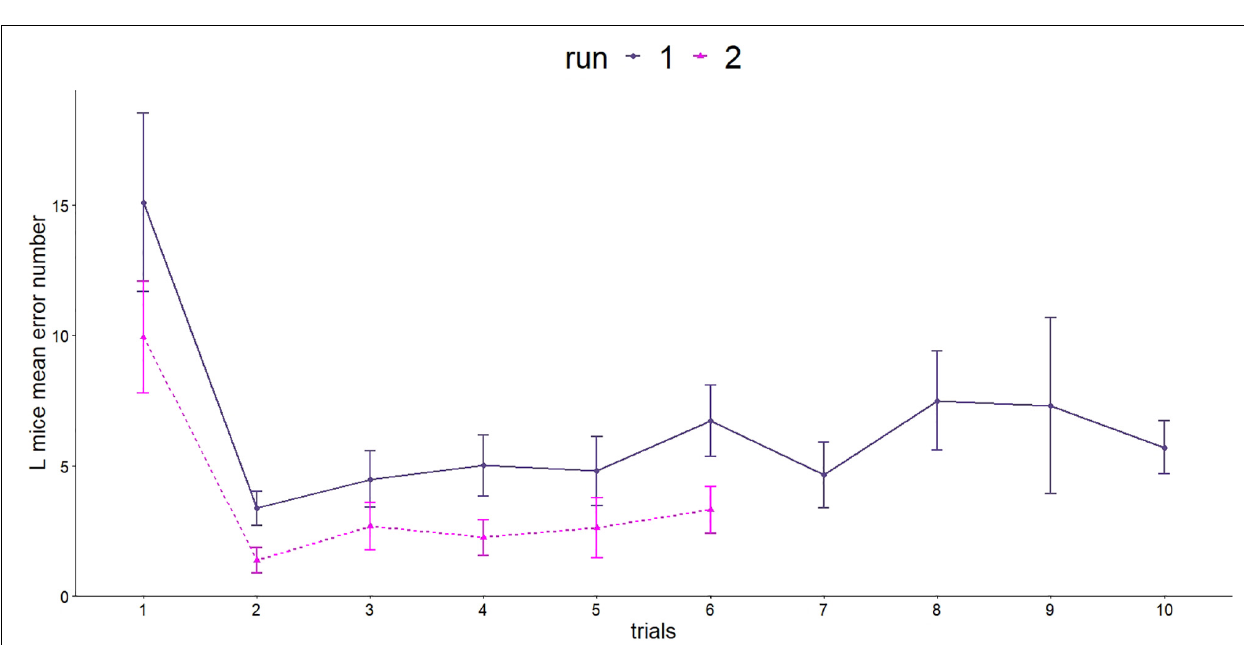
FIGURE 6 | Number of errors made in the Barnes maze test. Since the two runs were carried out differently (number of trials and length of trials), a separate statistical evaluation was carried out. First run, dark purple line: n = 16; age = 92 days; second run, purple line: n = 16, age = 573 days.